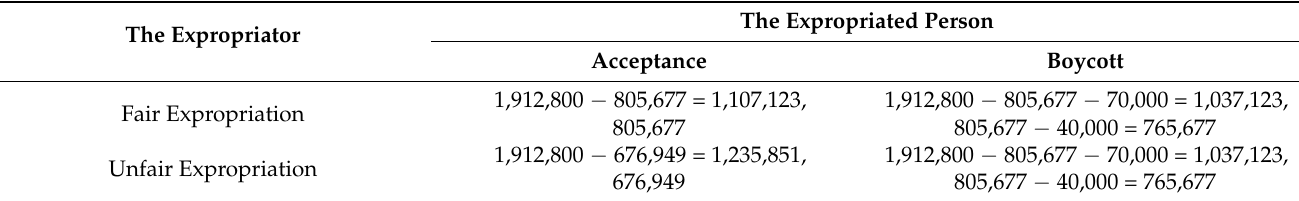
Table 8. The profit-seeking fairness game matrix of urban housing expropriation compensation to the east of the Friendship Store.